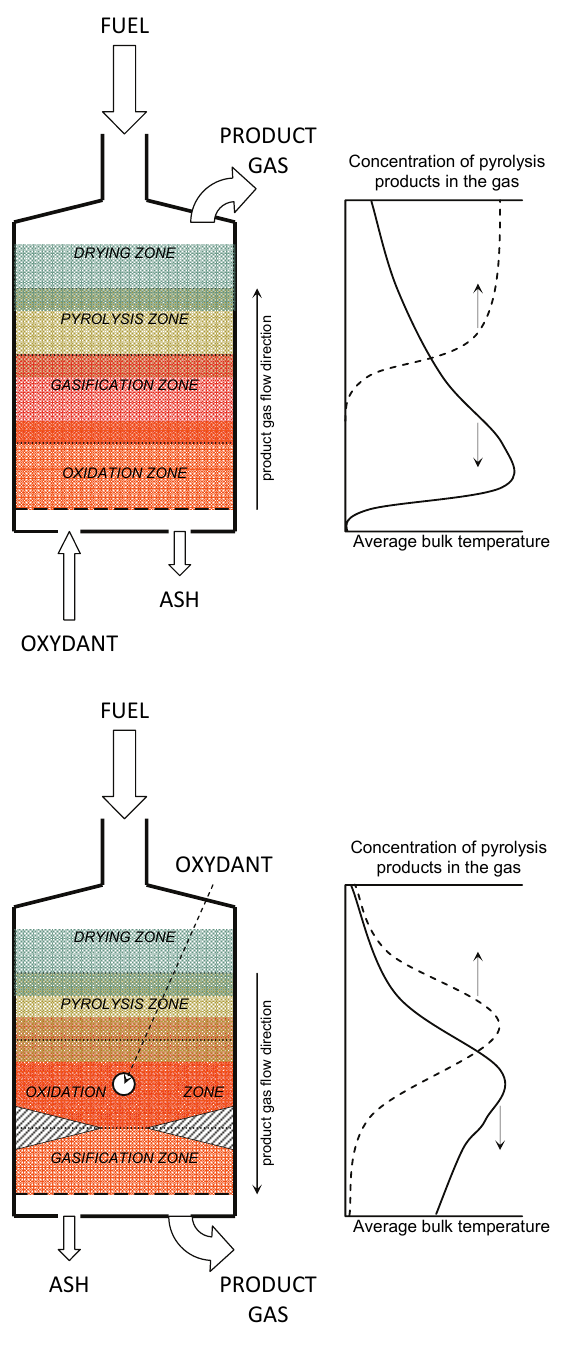
Figure 6 . Fixed Bed Updraft (top) and Downdraft (bottom) reactor schematics with the indication of the different reaction zones. Also the trends of the temperature profile and the concentration of pyrolysis products in the gas phase are shown. Adapted from [44] and